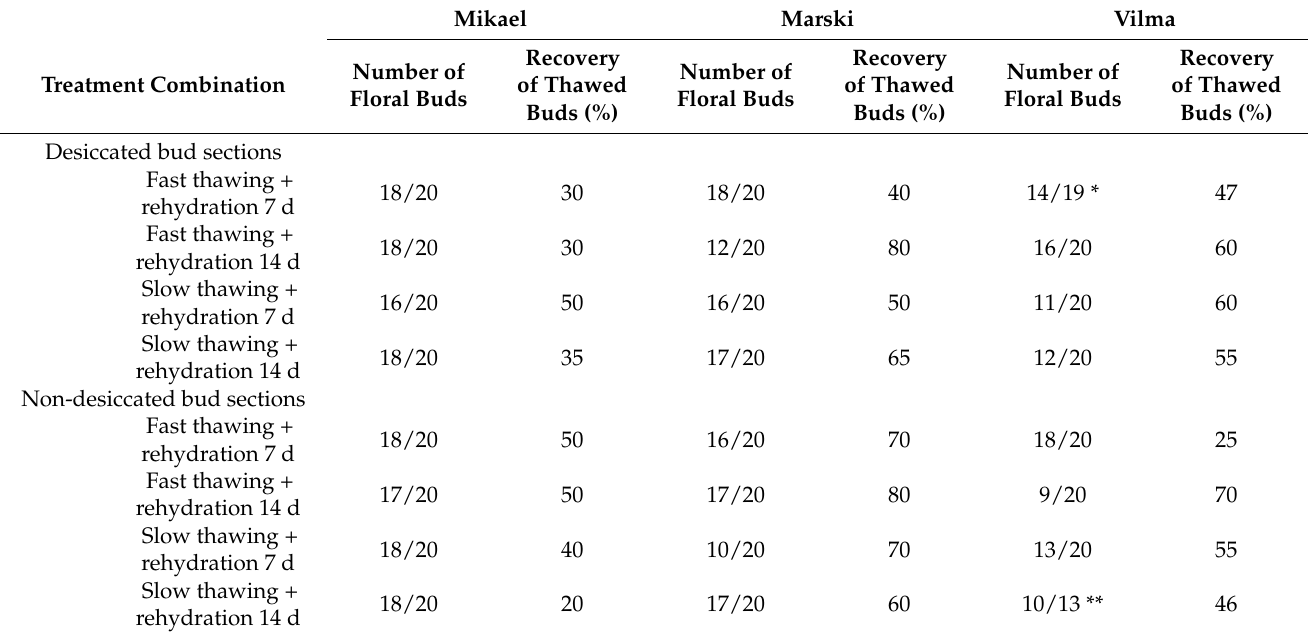
Table 1. The number of flower buds out of thawed buds and the actual recovery percentages (%) of the cryopreserved buds of blackcurrant cvs. Marski, Mikael, and Vilma per treatment combination. In each treatment combination, 20 bud sections were cryopreserved and thawed either slowly at 2 ◦ C or for 3 min in water bath at 38 ◦ C and rehydrated for 7 or 14 days (d). The actual recovery percentage of buds in vitro was calculated based on the number of regenerated buds related to the number of uncontaminated